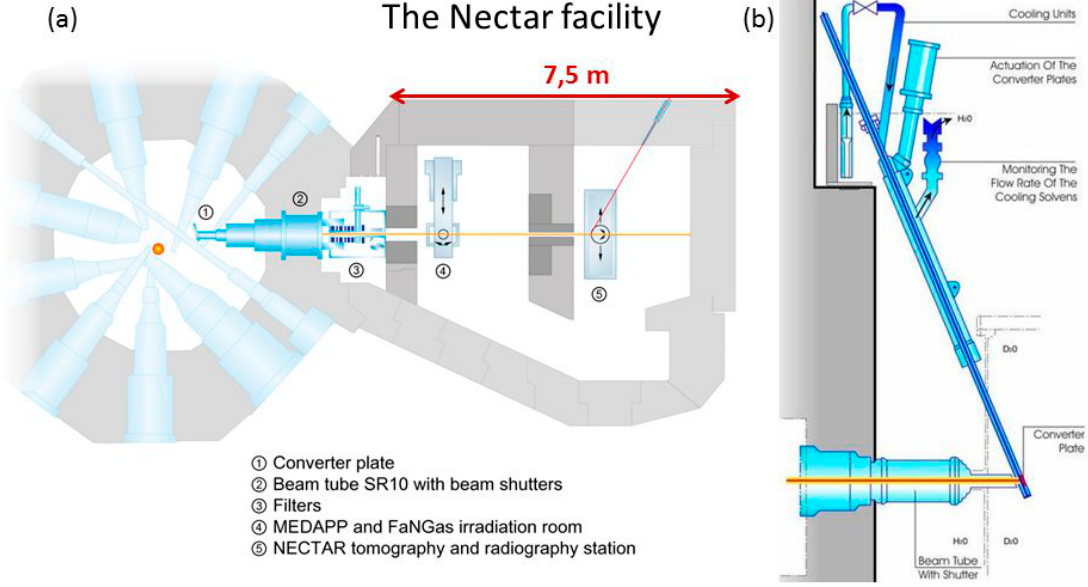
Figure 2. The NECTAR facility, ( a ) shows a sketch of the beamline, ( b ) the enriched uranium converter plate position (from [6,7] with